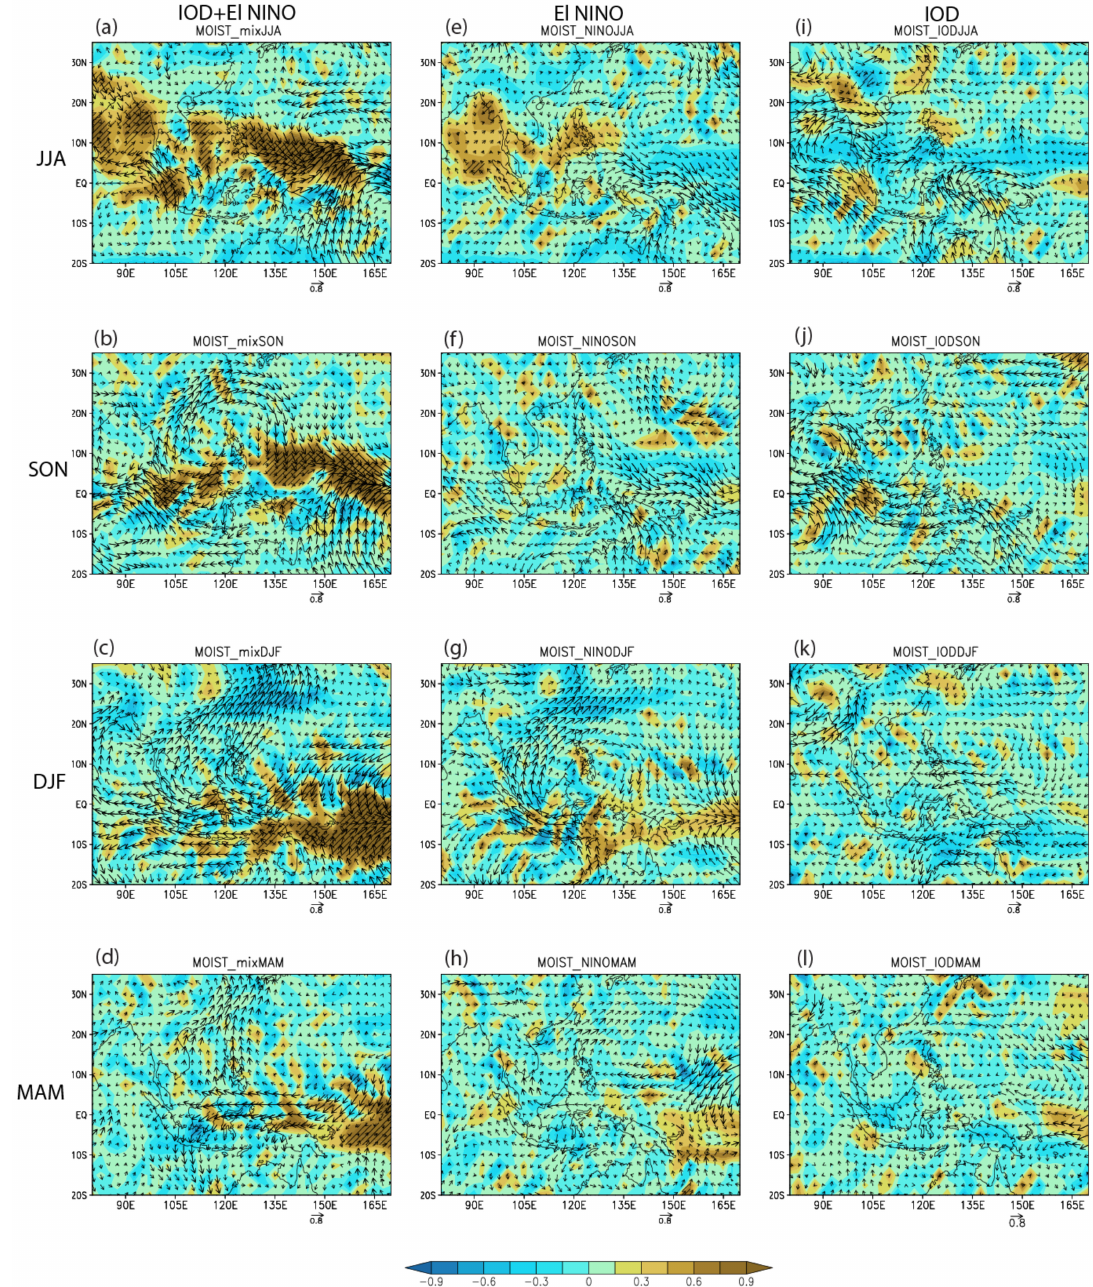
Figure 6. The composite of vertically integrated moisture flux (vectors) (kg m − 2 s − 1 ) and moisture flux divergence (shaded) (kg m − 2 s − 1 ) anomalies for the events listed in Table 1. The hatched and bolded vector indicates significance at the 95% level. ( a – d ) Co-occurrence of the conventional El Niño and positive IOD, ( e – h ) pure conventional El Niño, and ( i – l ) pure positive IOD for the seasons of JJA, SON, DJF, and